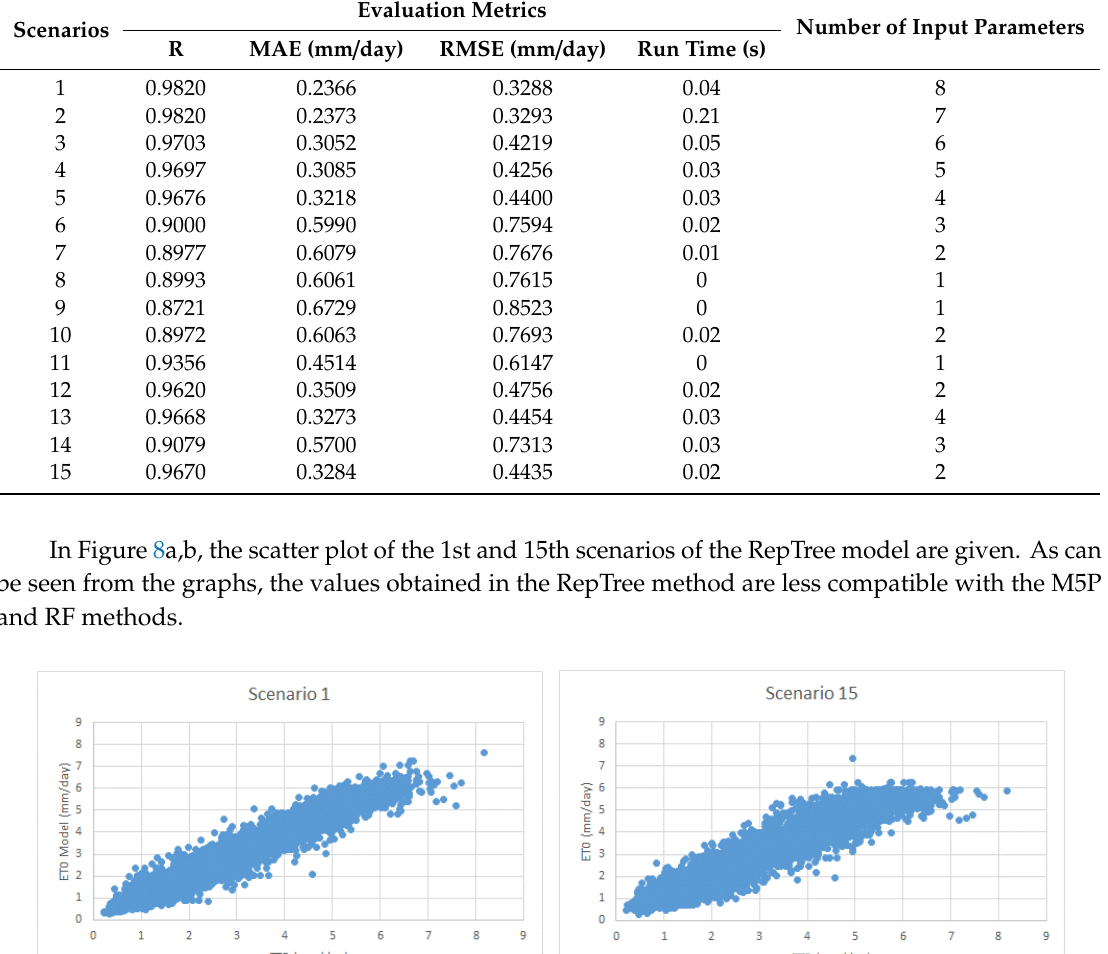
Table 8. GRU model results for 15 different scenarios.